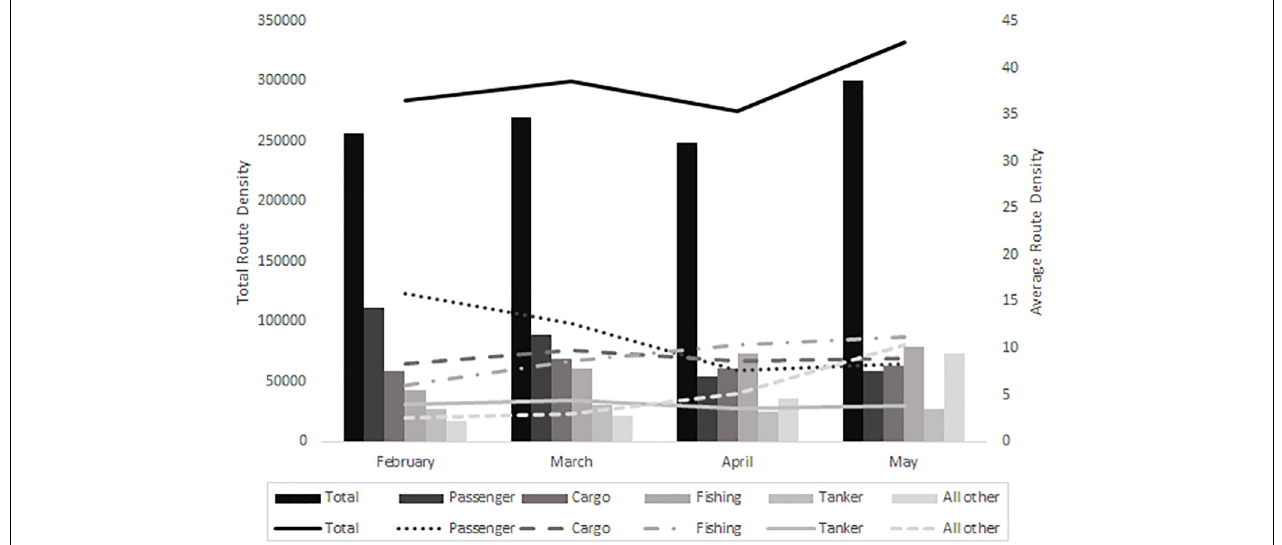
FIGURE 3 | Bar and line diagram showing the total (primary axis) and average (secondary axis) route density (routes per km 2 ) of the total, passenger, cargo, fishing, tanker, and all other types of ships within the 100 km 2 area around the Tisler reef.